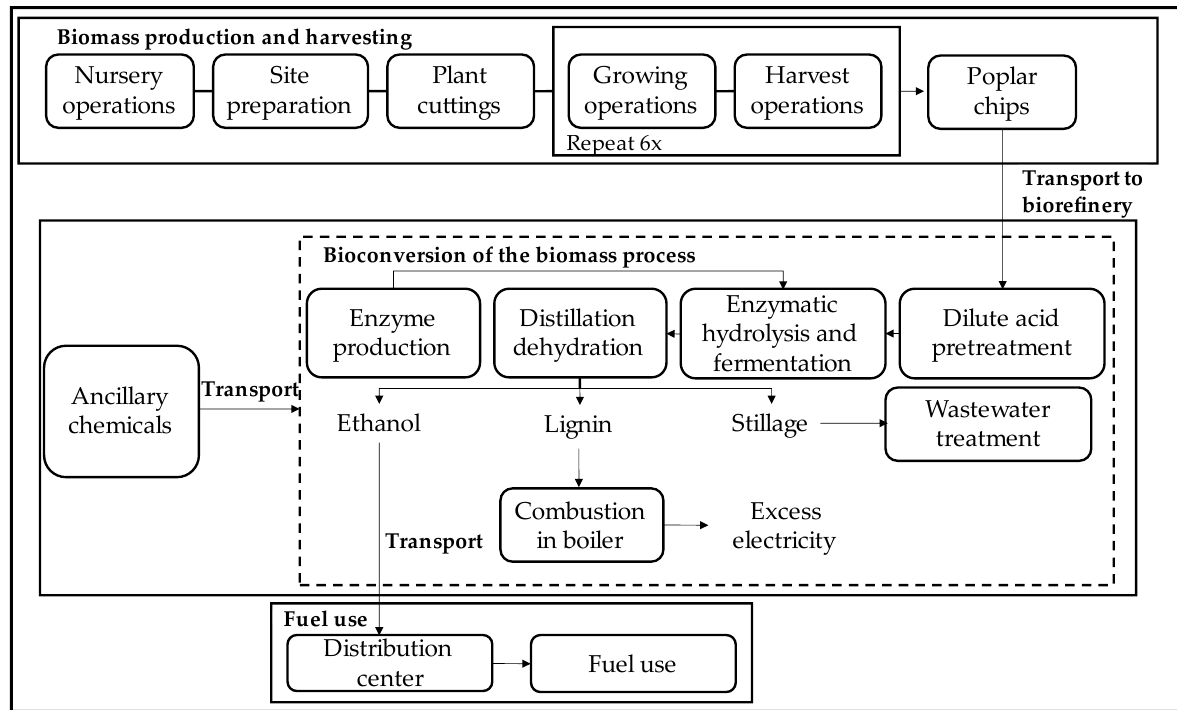
Figure 1. System boundaries of bioethanol production from a hybrid poplar.